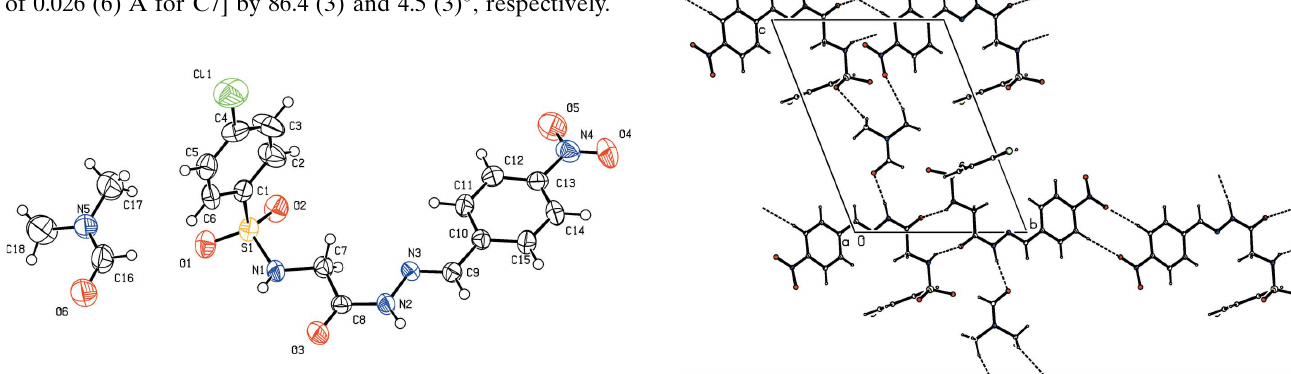
Figure 1 The molecular structure of the title compound with displacement ellipsoids drawn at the 50% probability level.